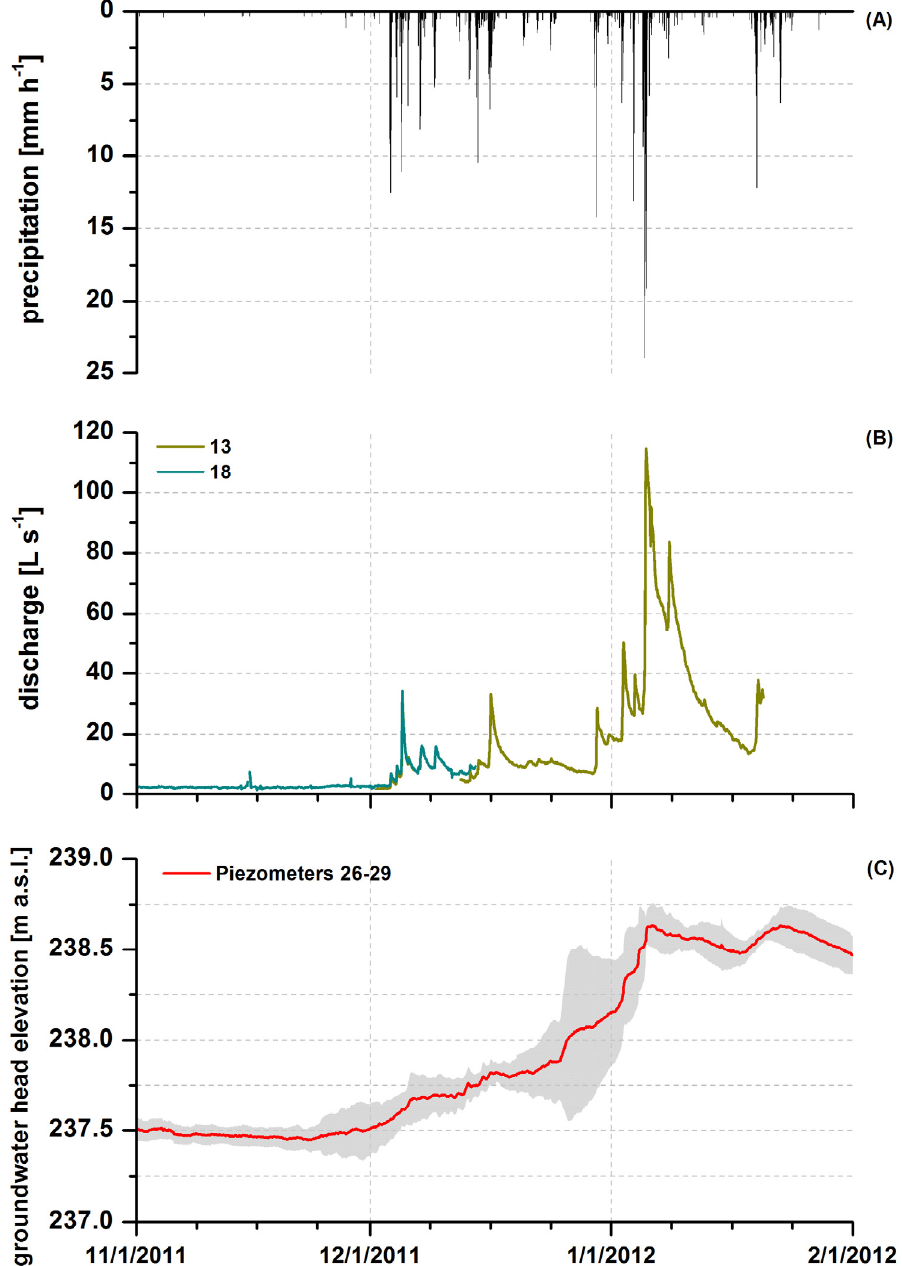
Figure 9. ( A ) Hourly precipitation (mm·h − 1 ); ( B ) hourly discharge (L·s − 1 ) at the lower and upper RBC-flume (13, 18); and ( C ) 15 min mean groundwater head elevations (m a.s.l.) for piezometers 26–29 (±SD, grey shaded) during the wetting up period (1 November 2011 – 1 February 2012). Note Mini-Divers ® malfunctions: from 14 December 2011, at